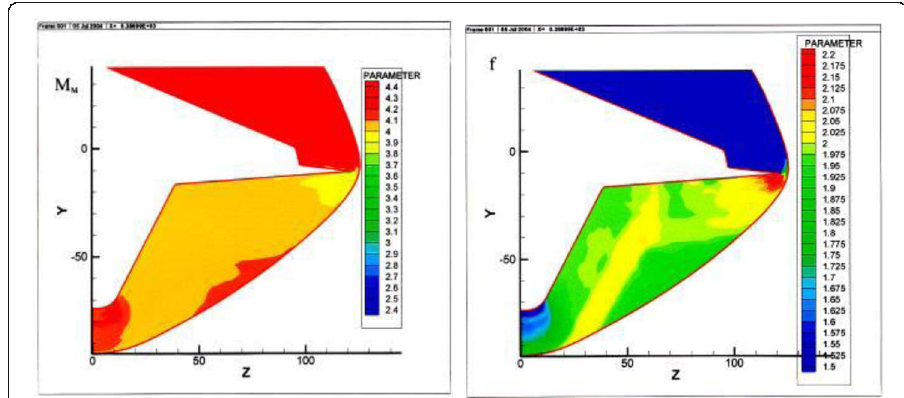
Fig. 5 Local Mach number (left) and mass flow function (right) distributions around the waverider, M ∞ = 5, α =